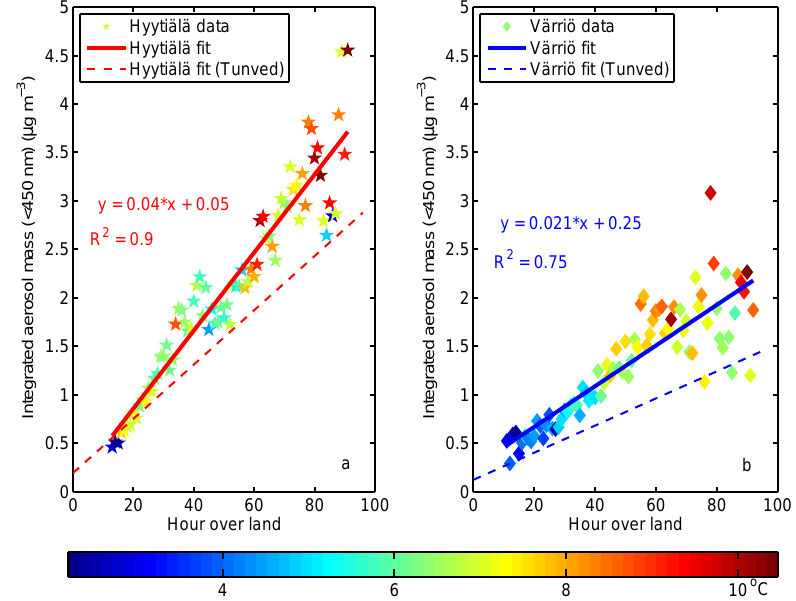
Figure 2. Average aerosol mass (particle size smaller than 450nm) vs. travelling hour over land of trajectories (a) at the SMEAR II station, and (b) at the SMEAR I station. Solid lines represent linear fits from data. Fitting slopes and their intercepts are written in the equations, together with their coefficients of determination ( R 2 ). Marker colours indicate the averaged temperature at each hour over land. The dashed lines are fitting slopes reported from Tunved et al. (2006) at these two stations.